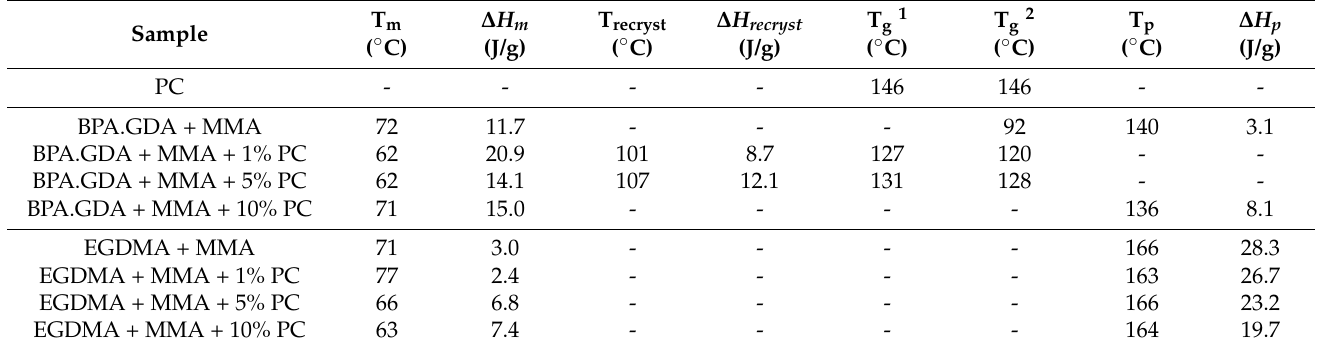
Table 3. Differential scanning calorimetry (DSC) data of obtained materials.